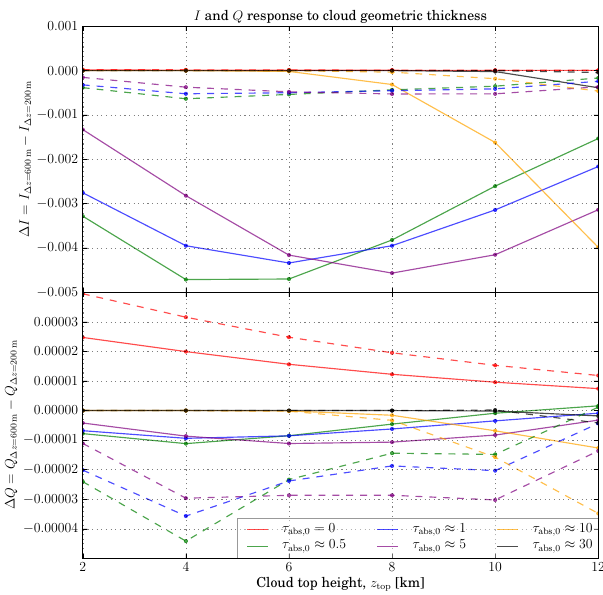
Figure 8. Height dependence of the change in intensity (cid:49)I (upper panel) and of (cid:49)Q (lower panel) due to a change in cloud thickness from (cid:49)z = 200m to (cid:49)z = 600m for different total column absorp- tion strengths (represented by different line colors). The solid lines represent a thick cloud of optical depth τ cloud = 10, while broken lines show a thin cloud of optical depth τ cloud =